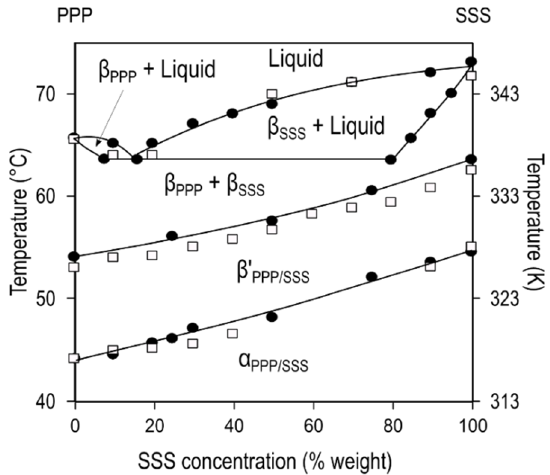
Figure 2. Phase diagram of PPP / SSS mixtures included in Macnaughtan et al. [75] (filled circles), with additional data from Lutton [74] (empty squares). Adapted with permission from [75], © 2006 American Oil Chemist’s Society.